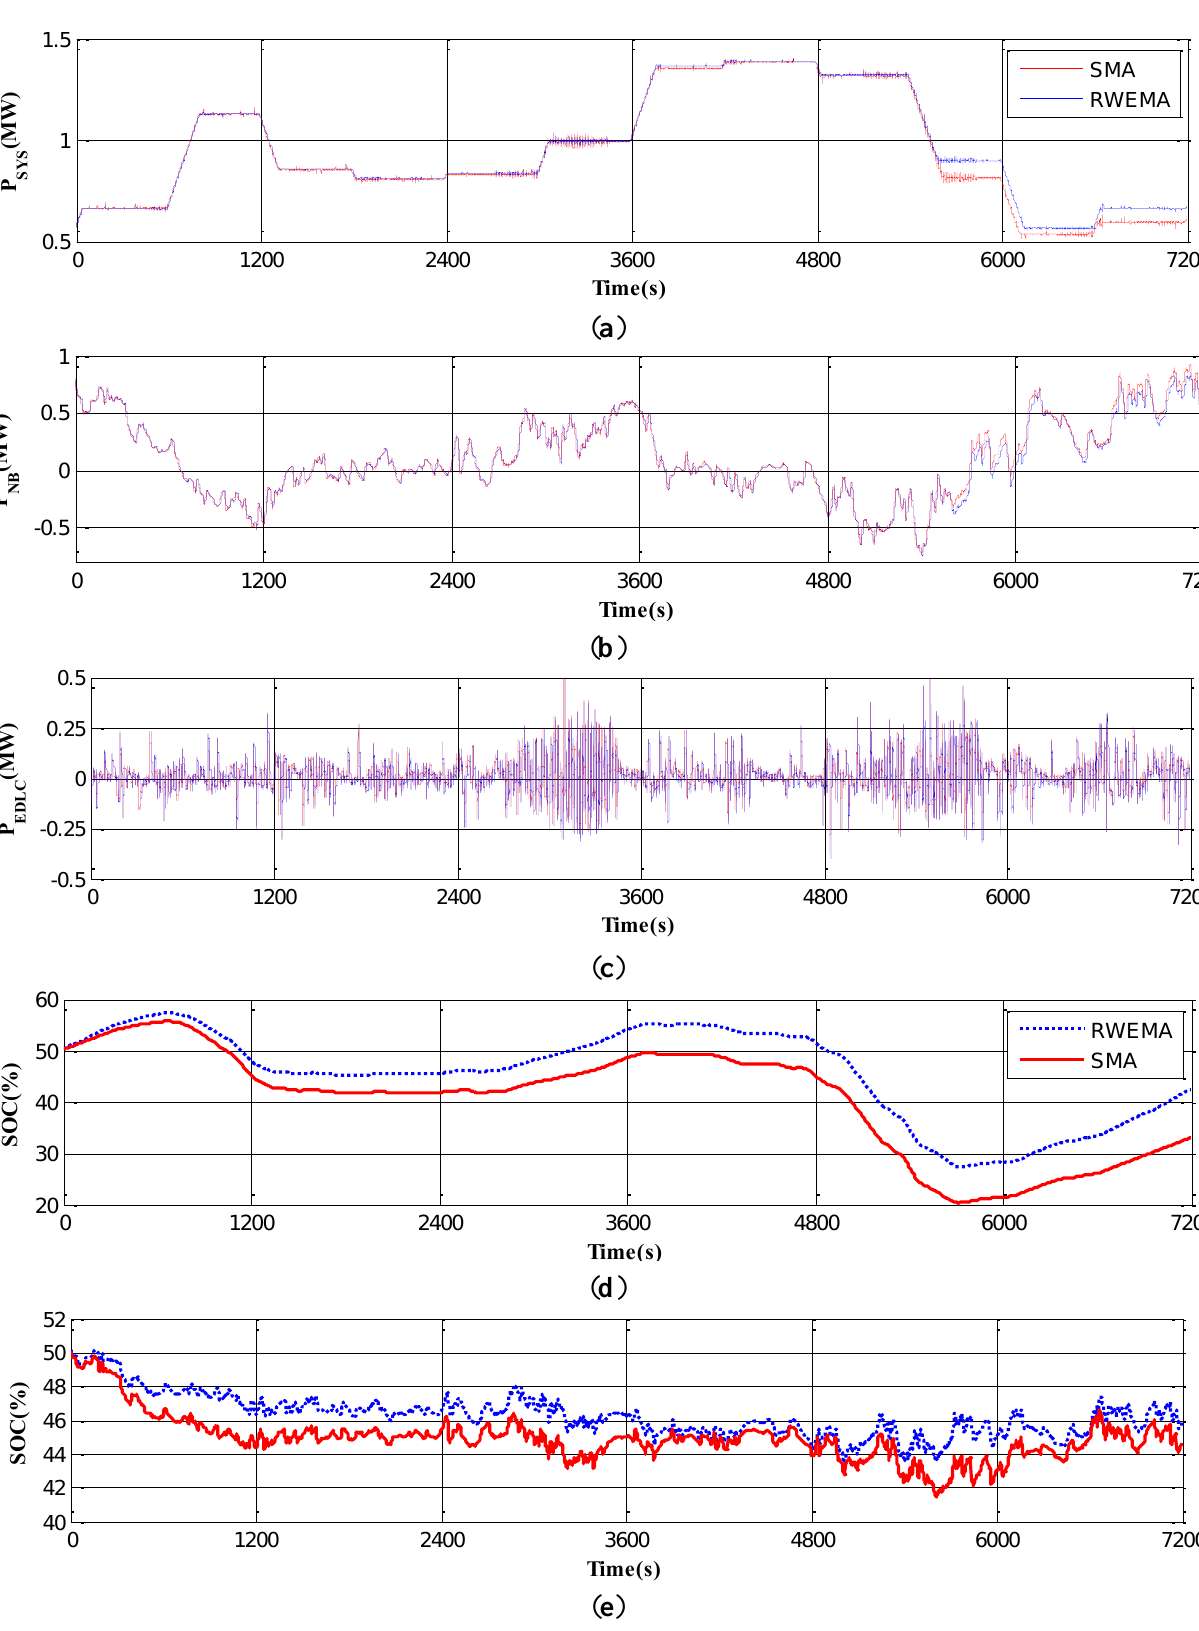
Figure 11. Simulation results for Case 2 with Wind Pattern 1: ( a ) total power output; ( b ) NB power output; ( c ) EDLC power output; ( d ) SOC level of NB; and ( e ) SOC level of